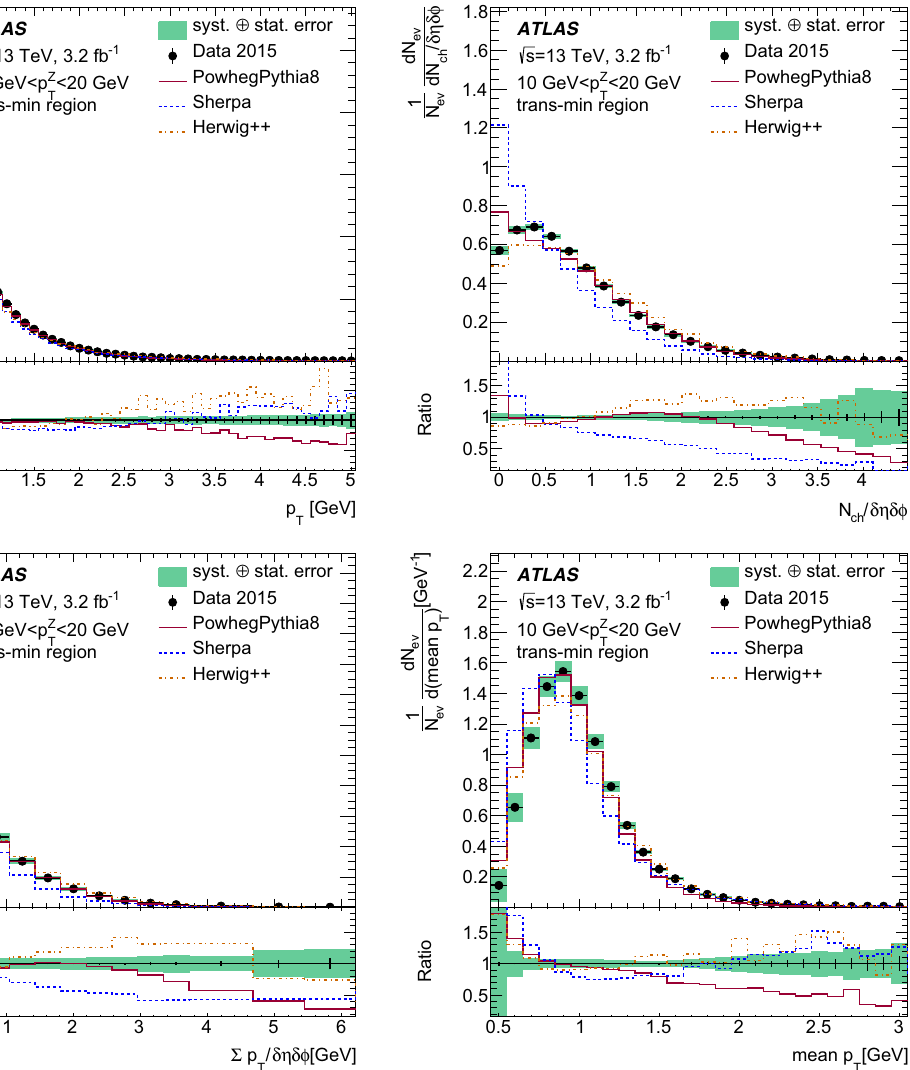
< 20 GeV. Predictions of Powheg + Pythia , for events with 10 < p Z T Sherpa and Herwig++ are compared with the data. The ratios shown are predictions over